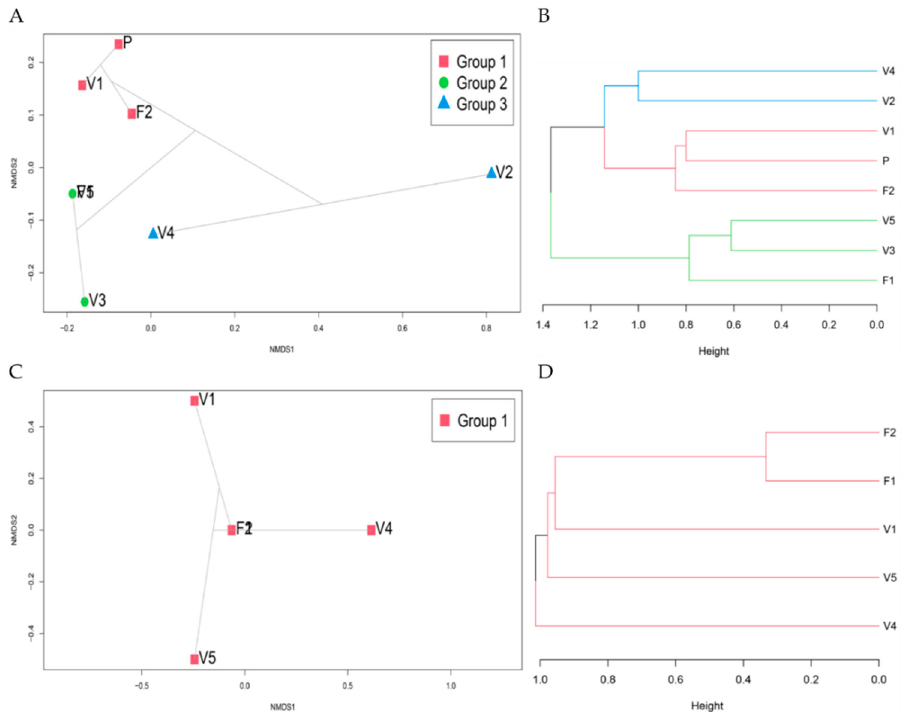
Figure 8. NMDS ordination plots based on the Bray-Curtis distances and ward cluster dendrograms. ( A ): NMDS plot of the filamentous fungal community; note that V5 and F1 are stacked together. ( B , D ) Ward cluster of filamentous fungal and yeast community, respectively. ( C ) NMDS plot of yeast community; note that F1 and F2 are stacked together.